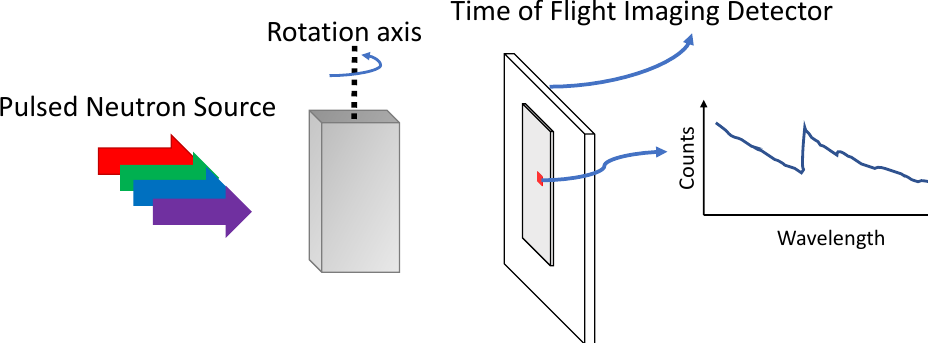
Figure 1. A block diagram of the wavelength-resolved neutron tomography setup at a spallation neutron source. An incident hyper-spectral neutron beam, depicted here with multiple color arrows each corresponding to a neutron wavelength, provides the transmission signal through a sample placed in front of the detector. A time-of-flight (TOF) imaging detector measures the number of neutrons detected as a function of time, which is equivalent to wavelength. These measurements can be binned into wavelengths to obtain a projection measurement corresponding to each wavelength and rotation